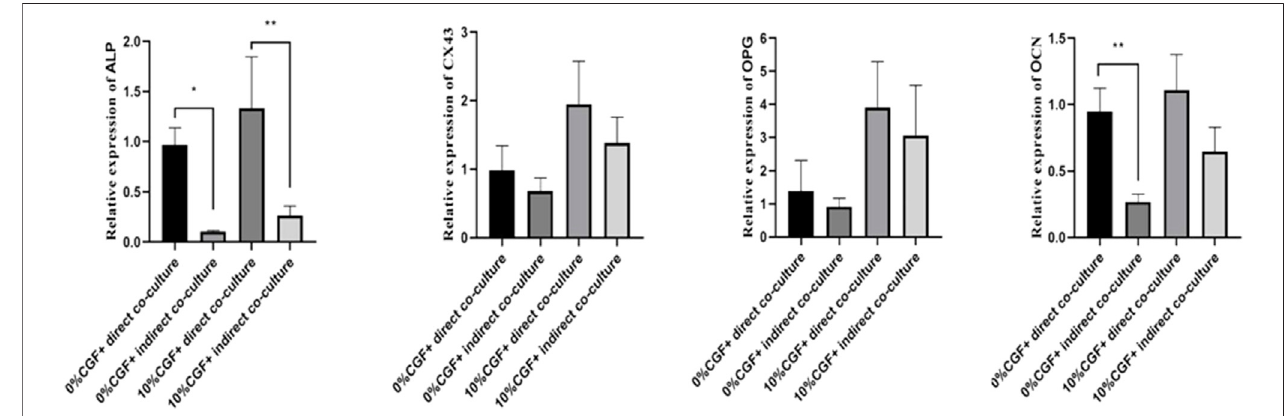
FIGURE 5 | Under 10% CGF, the relative expression of hBMSCs osteogenic-related genes in direct and indirect co-culture with HUVECs (* p < 0.05, ** p < 0.01, *** p < 0.001, **** p <